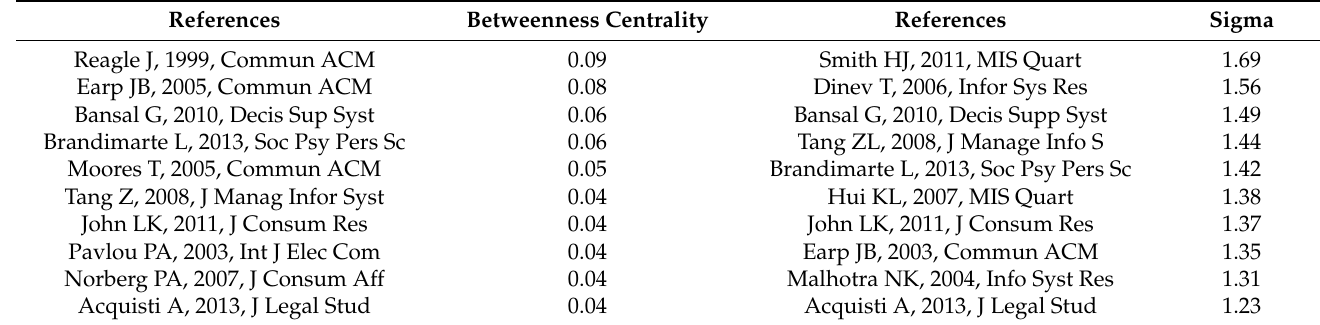
Table 4. Top 10 betweenness centrality and sigma references.